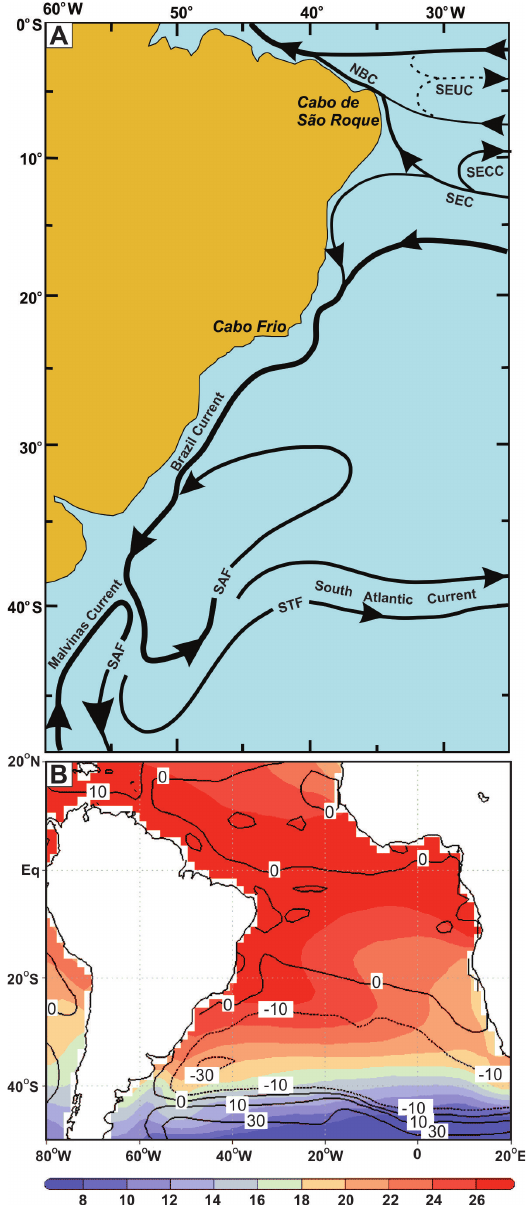
Fig. 2. The South Atlantic Ocean. (a) Upper-level barotropic cur- rents and fronts on the Brazilian continental margin, western South Atlantic Ocean: NBC – North Brazilian Current; SEUC – South Equatorial Under Current; SECC – South Equatorial Countercur- rent; SEC – South Equatorial Current; SAF – Subantarctic Front; STF – Subtropical Front; adapted from Peterson and Stramma (1991). (b) Austral summer (December to February) barotropic stream function in sverdrup (Sv) (dashed and solid lines, Salas- Melia et al., 2005), and Era-Interim sea surface temperature in de- grees Celsius ( ◦ C) (shaded colours, Dee et al., 2011).